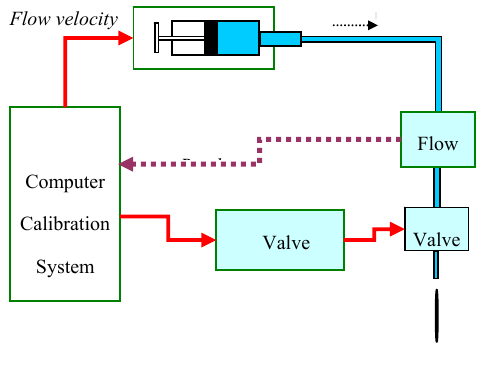
Figure 8. The schematic of experimental set up for flow-voltage